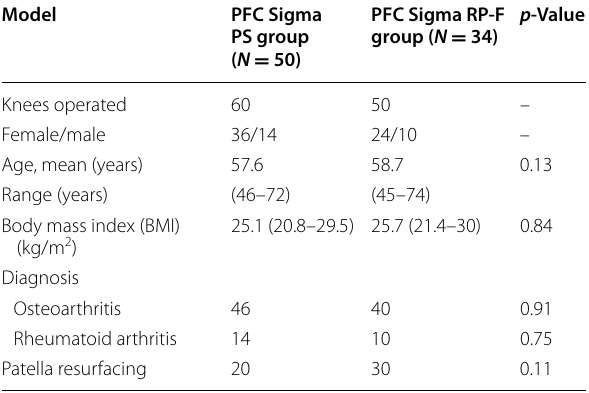
Table 1 General demographic features for all patients in the study